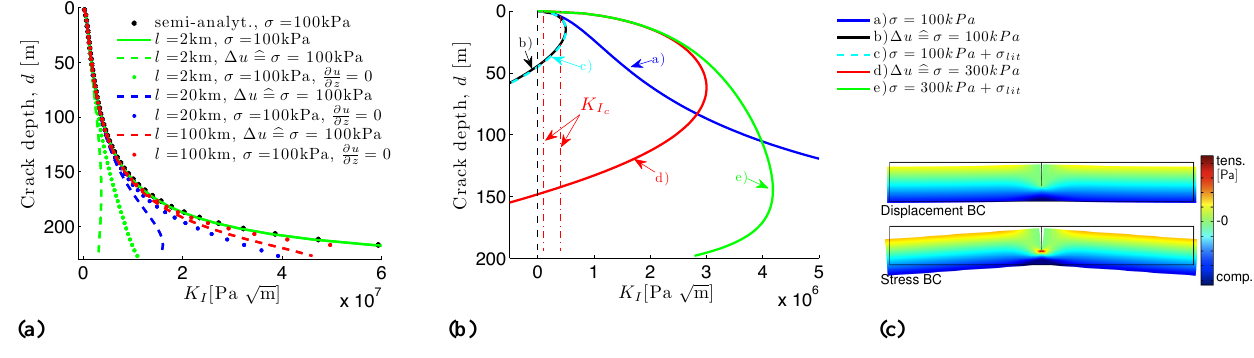
Fig. 4. (a) Stress intensity factors for different BC and domain lengths without volume forces. (b) Stress intensity factors for different BC, l = 2000m and volume forces. (c) Qualitative contour plot of the normal stress σ xx for displacement and equivalent stress